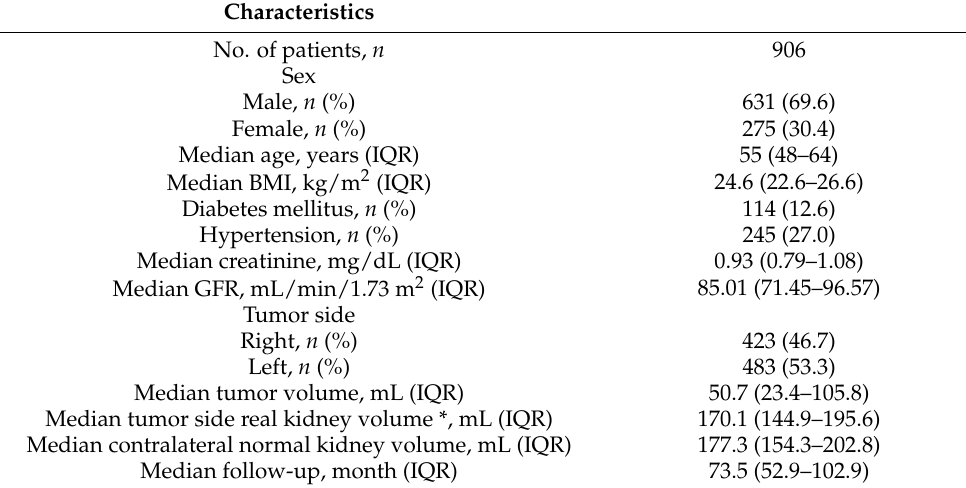
Table 1. Baseline characteristics of patients who underwent radical nephrectomy.